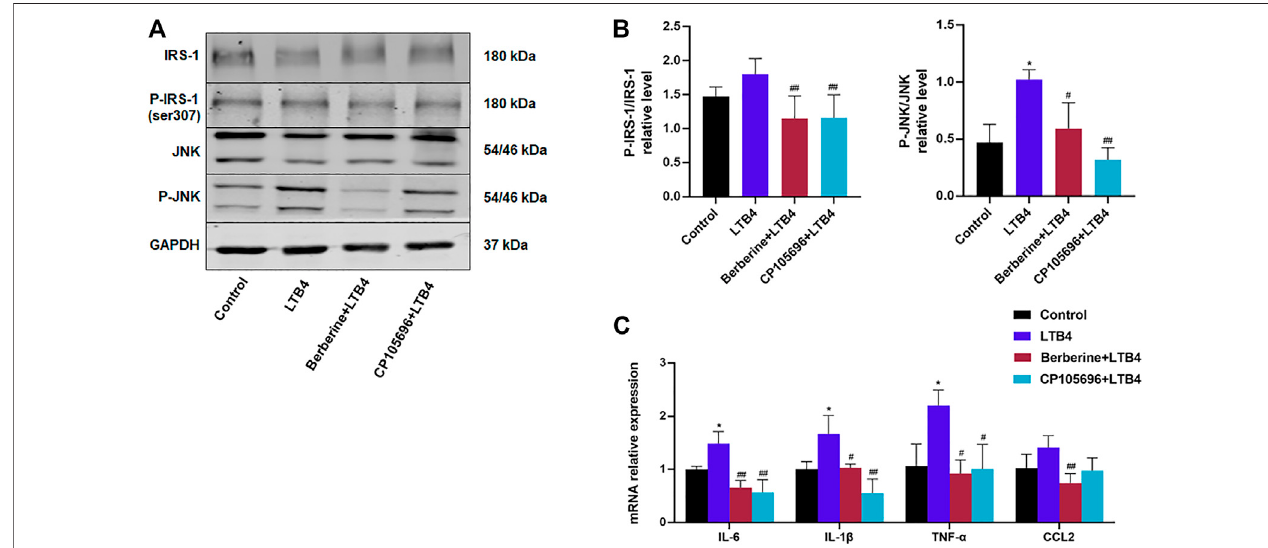
FIGURE 2 | BBR attenuated the in fl ammation response of HepG2 cells induced by LTB4. (A) Western blots showed p-IRS-1 and p -JNK protein levels in HepG2 cells. (B) Densitometric analysis of p-IRS-1 and p -JNK in total protein was calculated ( n (cid:2) 3 – 5). (C) Gene expressions of IL-6, TNF- α , IL-1 β , and CCL2 were determined by RT-PCR ( n (cid:2) 4). Error bars represent mean ± SD. BBR, Berberine, 10 μ M; CP105696, 10 μ M; LTB4, Leukotriene B4, 100 nM * p < 0.05 vs. Control; # p < 0.05 vs. LTB4. ** p < 0.01; ## p <